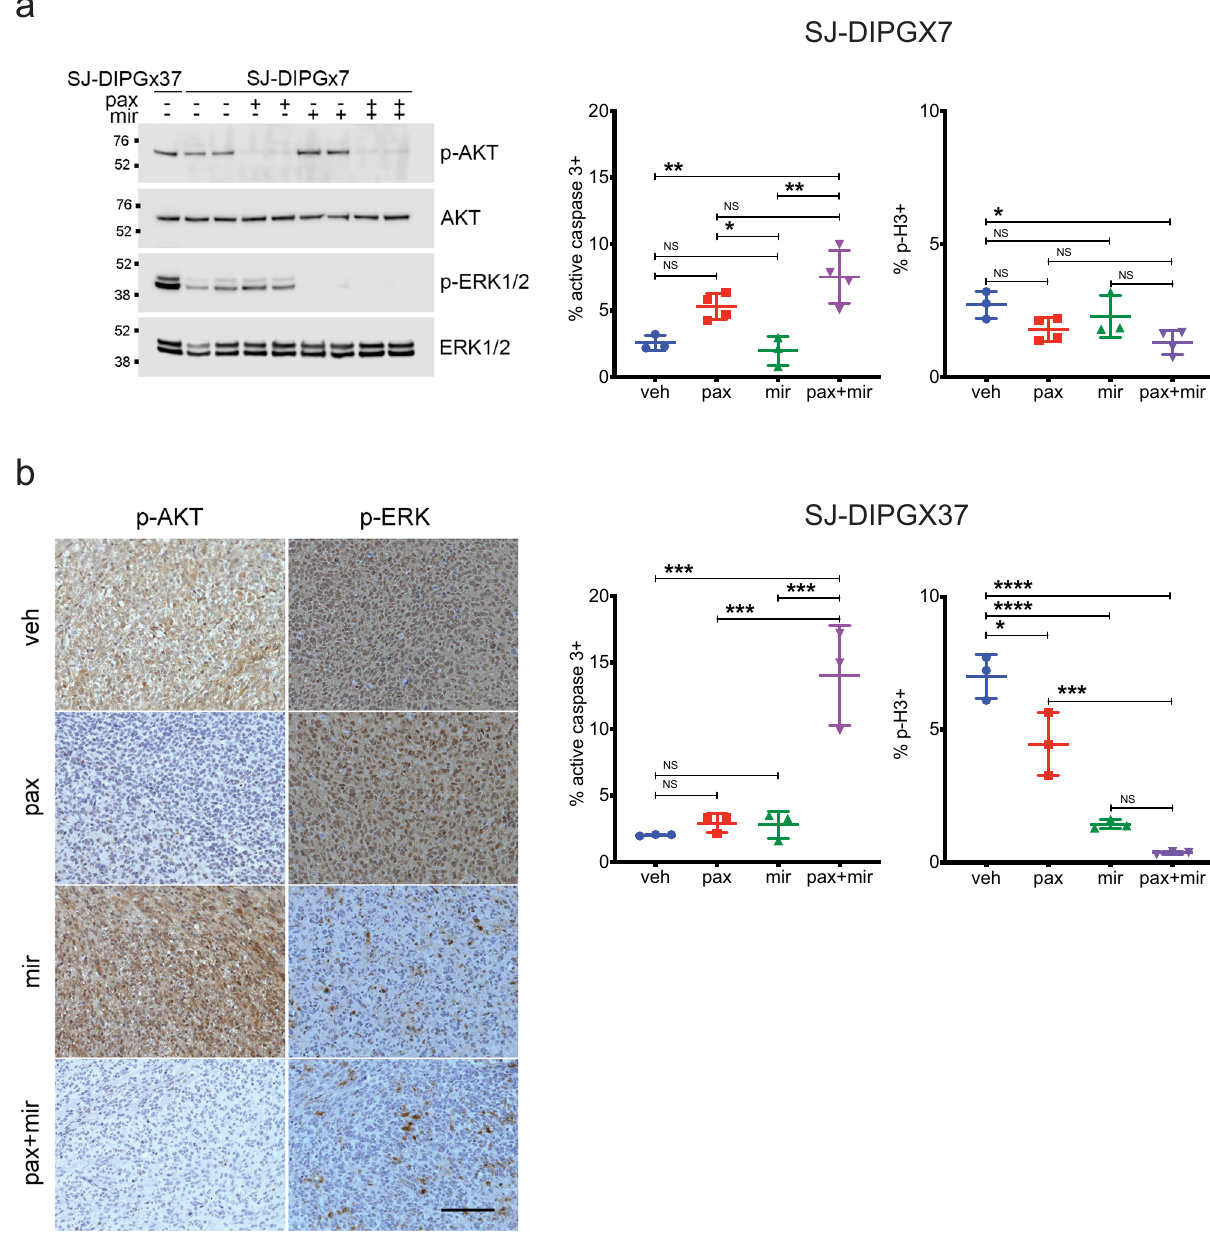
Fig. 8 Paxalisib and mirdametinib show selective effects on cell survival and proliferation in vivo. a Left: A single western blot of lysates from intracranial PDOX SJ-DIPGX37 (untreated, lane 1) and SJ-DIPGX7 (lanes 2 – 9) treated with vehicle (veh), paxalisib (pax, 12 mg/kg), mirdametinib (mir, 17 mg/kg), or the combination of paxalisib and mirdametinib (pax + mir) as indicated; antibodies are indicated at right. Quanti fi cation of IHC in sections from SJ-DIPGX7 tumors treated with agents shown along the x- axis for active caspase-3 (middle) and phospho-histone H3 (right), n = 3 tumors for veh, mir and n = 4 tumors for pax and pax + mir. The p values for comparison of active caspase-3 staining are veh vs. mir 0.9454, veh vs. pax 0.0964, veh vs. pax + mir 0.0032, mir vs. pax 0.0383, mir vs. pax + mir 0.0014, and pax vs. pax + mir 0.1474. The p values for comparison of p-H3 staining are veh vs. mir 0.7418, veh vs. pax 0.1733, veh vs. pax + mir 0.0258, mir vs. pax 0.6600, mir vs. pax + mir 0.1435, and pax vs. pax + mir 0.5747. b Left: IHC for pAKT Ser473 and pERK in SJ-DIPGX37 tumors in representative tumors treated with veh, pax, mir, or pax + mir as indicated. Quanti fi cation of IHC staining in sections from SJ-DIPGX37 tumors treated with agents shown along the x- axis for active caspase-3 (middle) and phospho-histone H3 (right), n = 3 tumors for each treatment. The p values for comparison of active caspase-3 staining are veh vs. mir 0.9628, veh vs. pax 0.9405, veh vs. pax + mir 0.0003, mir vs. pax 0.9997, mir vs. pax + mir 0.0005, and pax vs. pax + mir 0.0006. The p values for comparison of p-H3 staining are veh vs. mir < 0.0001, veh vs. pax 0.0110, veh vs. pax + mir < 0.0001, mir vs. pax 0.0043, mir vs. pax + mir 0.3352, and pax vs. pax + mir 0.0006. NS not signi fi cant; * p < 0.05; ** p < 0.01; *** p < 0.001, **** p < 0.0001 using ordinary one-way ANOVA with post hoc Tukey test. The error bars indicate the mean ± s.d. Scale bar in b , left panel = 100 µ